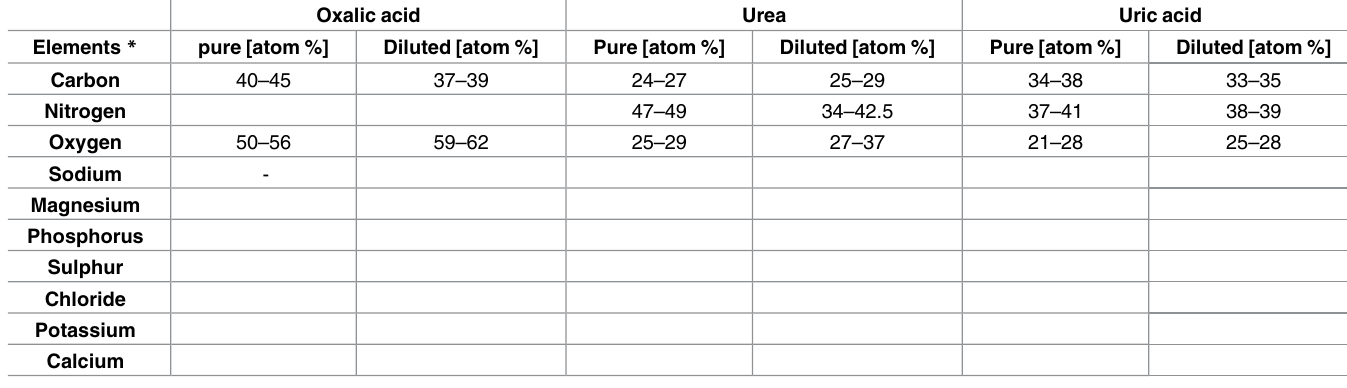
Table 3. EDX values of the different elements and chemicals, given in atomic%, typically produced by